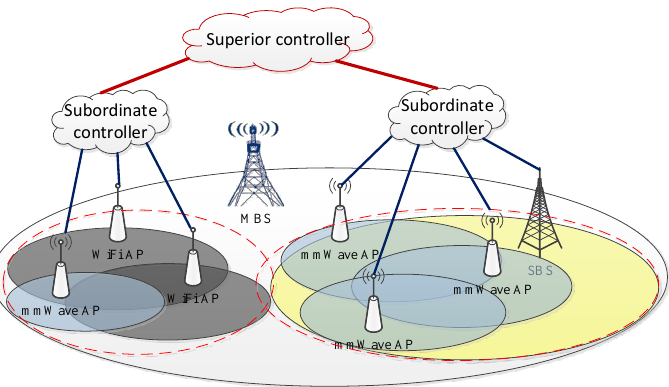
Figure 1. The proposed mmWave HetNet